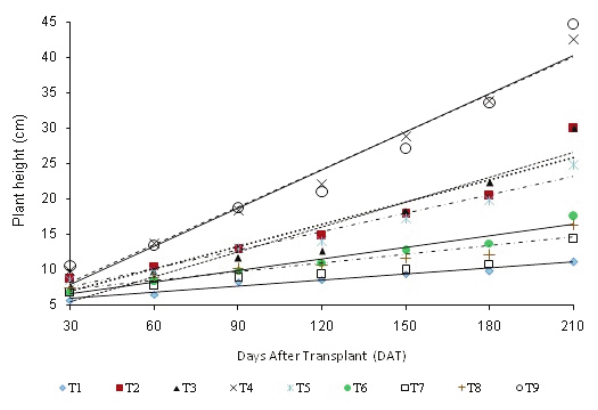
Fig. 1 ­ Effect of different combinations of substrates on plant height in açai seedlings ( Euterpe oleracea Mart.) under nursery conditions. T1= sand, T2= commercial substrate (OrganoAmazon © ), T3= 25% T1 + 75% manure, T4= 50%